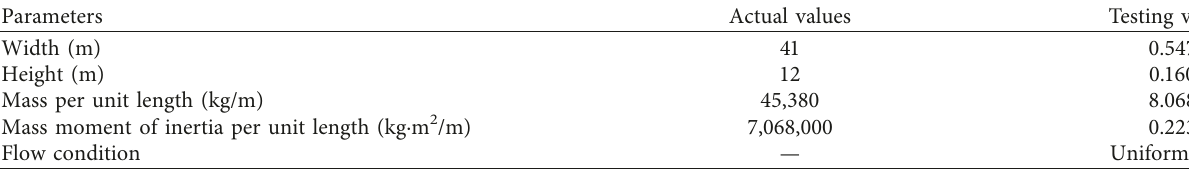
Table 1: Design parameters of wind tunnel